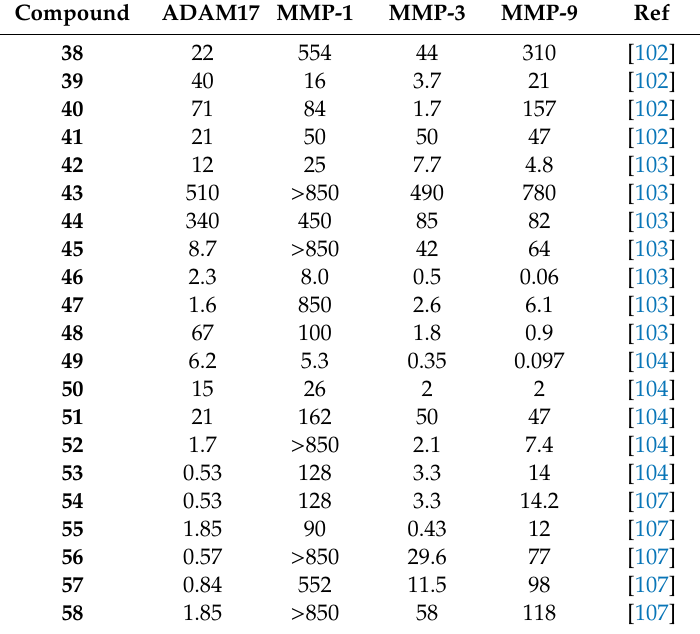
Table 2. Inhibitory activity (IC 50 nM) of azasugar-based metzincin inhibitors against ADAM17 and MMP-1, -3,